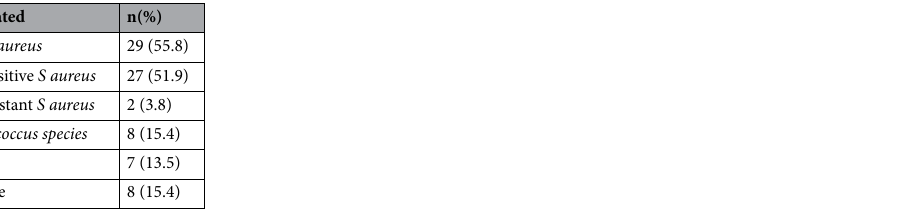
Table 3. Aetiological pathogens isolated from blood cultures or intraoperative specimens and outcome after OPAT.